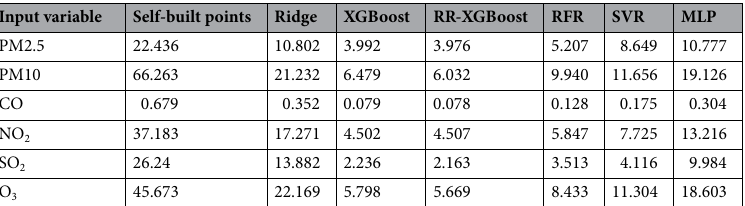
Table 8. RMSE of six types of air pollutant concentrations between self− built points, model forecast values and national control